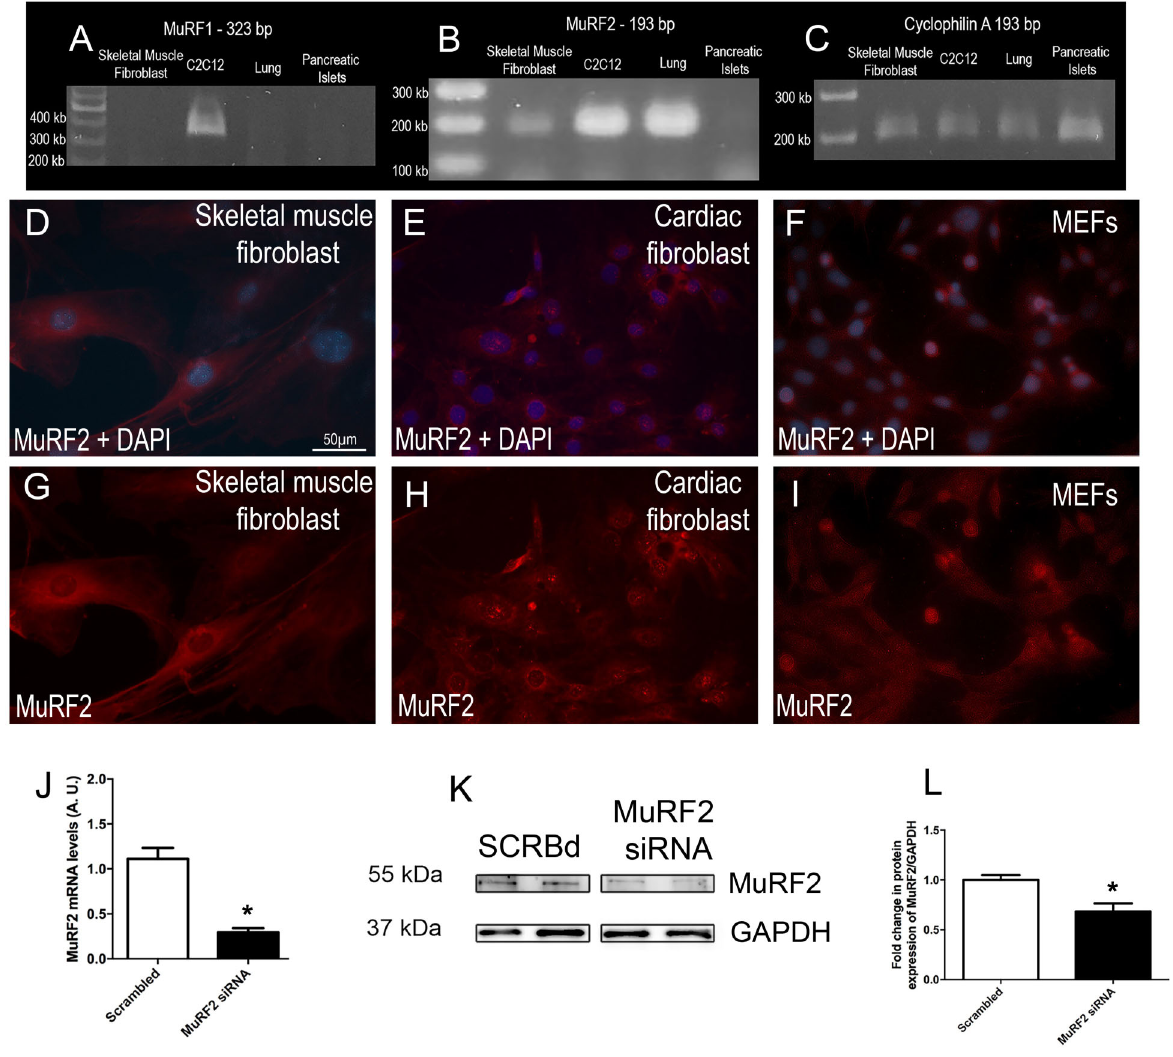
Figure 2. MuRF2 is expressed in fi broblasts. Semi-quantitative PCR for MuRF1 ( A ) and MuRF2 ( B ), and cyclophilin as a housekeeping gene ( C ) in skeletal muscle fi broblasts, C2C12, lung, and pancreatic islets. Immuno fl uorescence for MuRF2 in skeletal muscle fi broblasts ( D and G ), cardiac fi broblasts ( E and H ), and mouse embryonic fi broblasts (MEFs) ( F and I ). J : Real-time PCR in skeletal muscle fi broblasts treated with scrambled (SCRBd) or MuRF2 siRNA. K : Representative immunoblots for MuRF2 and GAPDH in skeletal muscle fi broblasts treated with SCRBd or MuRF2 siRNA. The images belong to the same membrane. L : Relative band intensities were determined by densitometry. Scale bar, 50 m M ( D-I ). Data are reported as means ± SE. *P o 0.05 vs SCRBd (Student ’ s t